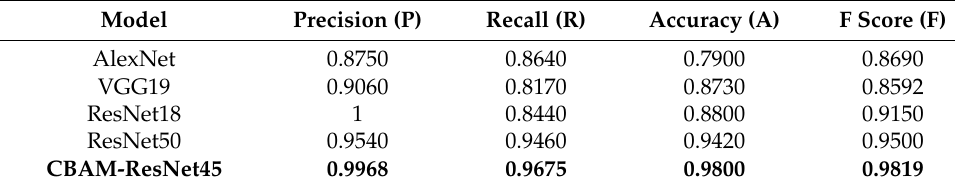
Table 4. The indicators for the evaluation of the performance of